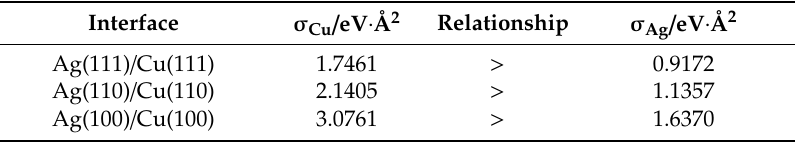
Table 3. The relationship between two surfaces and